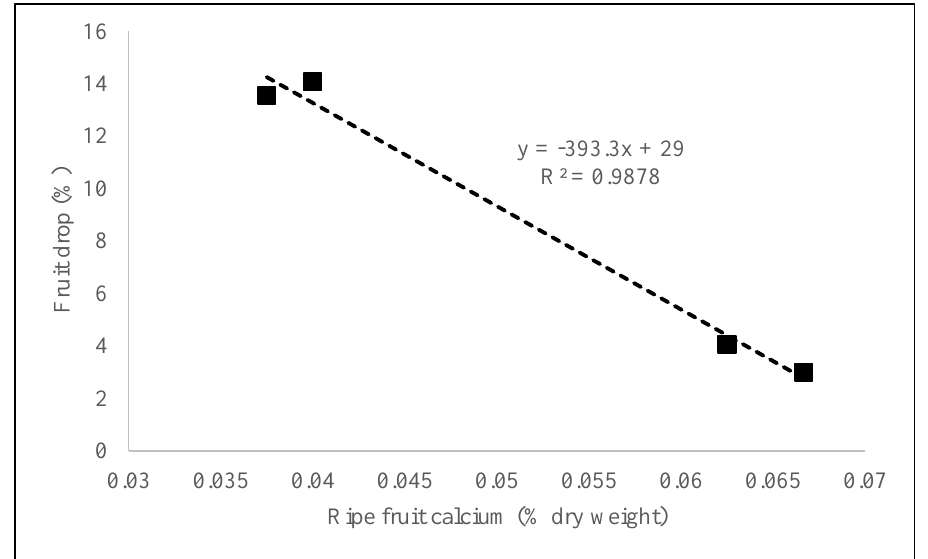
Figure 1. XY plots with regression equations and coefficients of determination between percent fruit drop and ripe fruit calcium for ‘Draper’ highbush blueberry treated (right) and non-treated (left) with foliar Ca under high and low nitrogen conditions on a single farm site in Abbotsford, British Columbia, Canada in 2014.